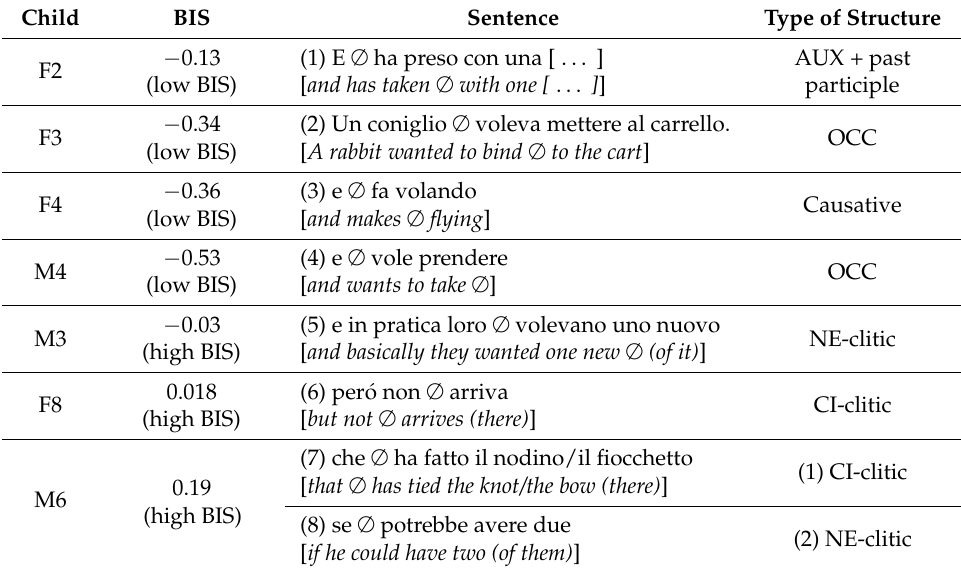
Table 7. Cases of clitic omission occurring in the narratives. The first column indicates the subject that produced the sentence, the second her BIS, and the fourth the type of structure in which the clitic is missing or the type of clitic that is missing.